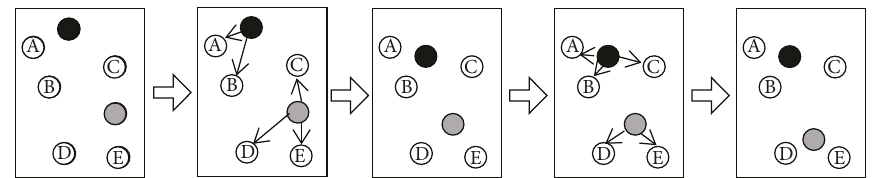
Figure 6: Demonstration of k-means